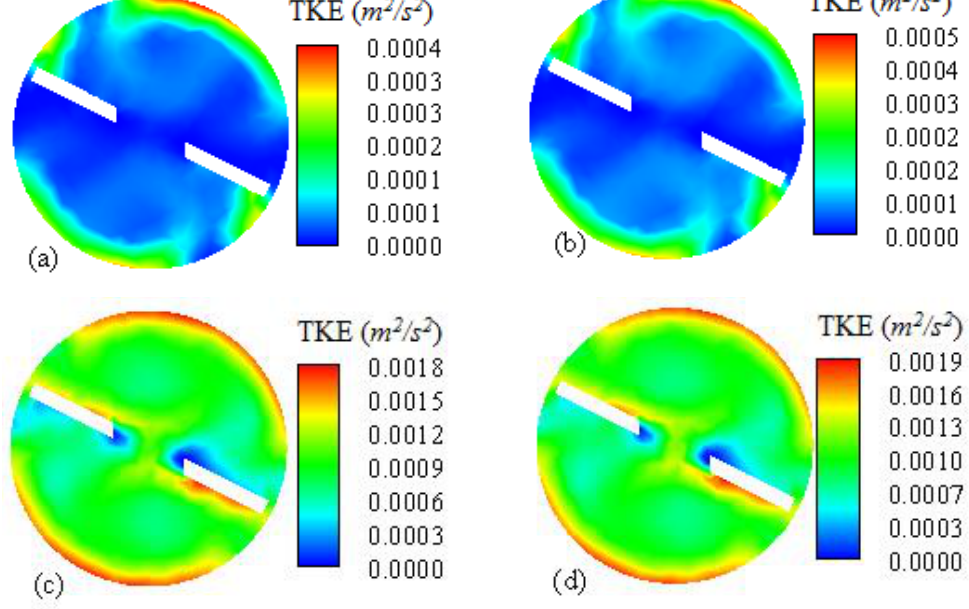
Figure 6. TKE at axial location of 0.134 m before the flow end of the C-T tube’s cross-section for (a) 𝑹𝒆 = 𝟐, 𝟏𝟓𝟎 , (b) 𝑹𝒆 = 𝟐, 𝟑𝟎𝟎 , (c) 𝐑𝐞 = 𝟒,𝟒𝟎𝟎 , and (d) 𝑹𝒆 = 𝟒,𝟔𝟓𝟎